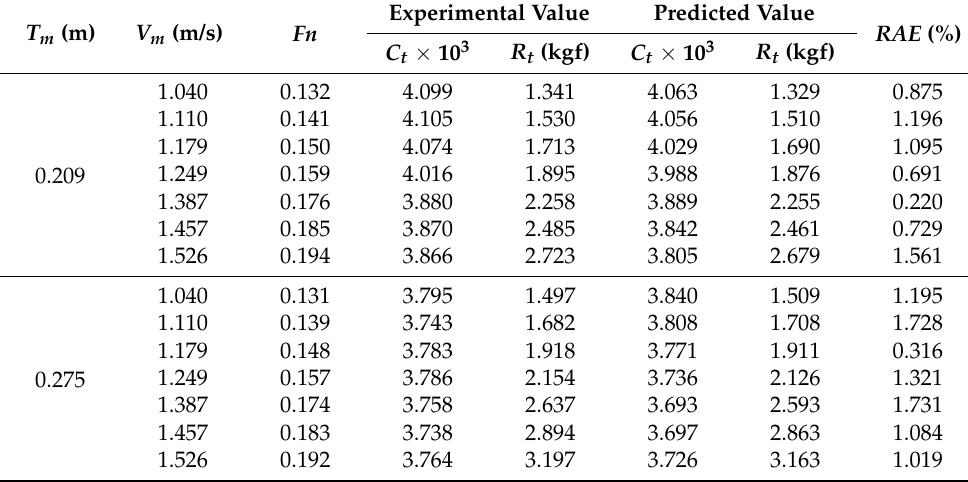
Table 11. The experimental values and predicted values of test set by the best performing